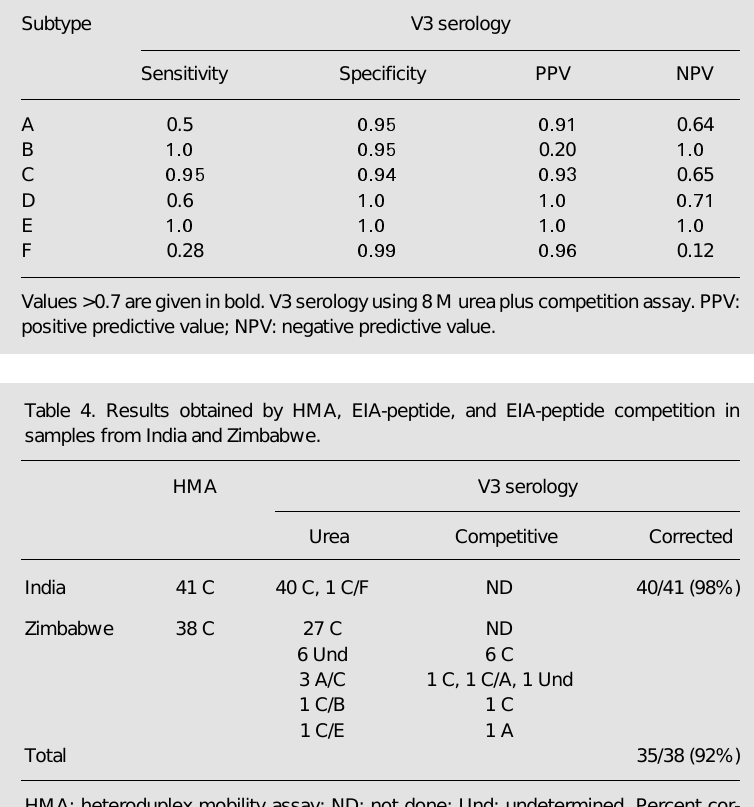
rected using urea and competitive assay results.